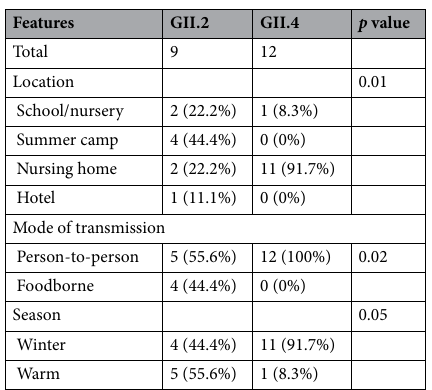
Table 3. Characteristics of outbreaks caused by norovirus GII.2 and GII.4 according to location, mode of transmission and season.